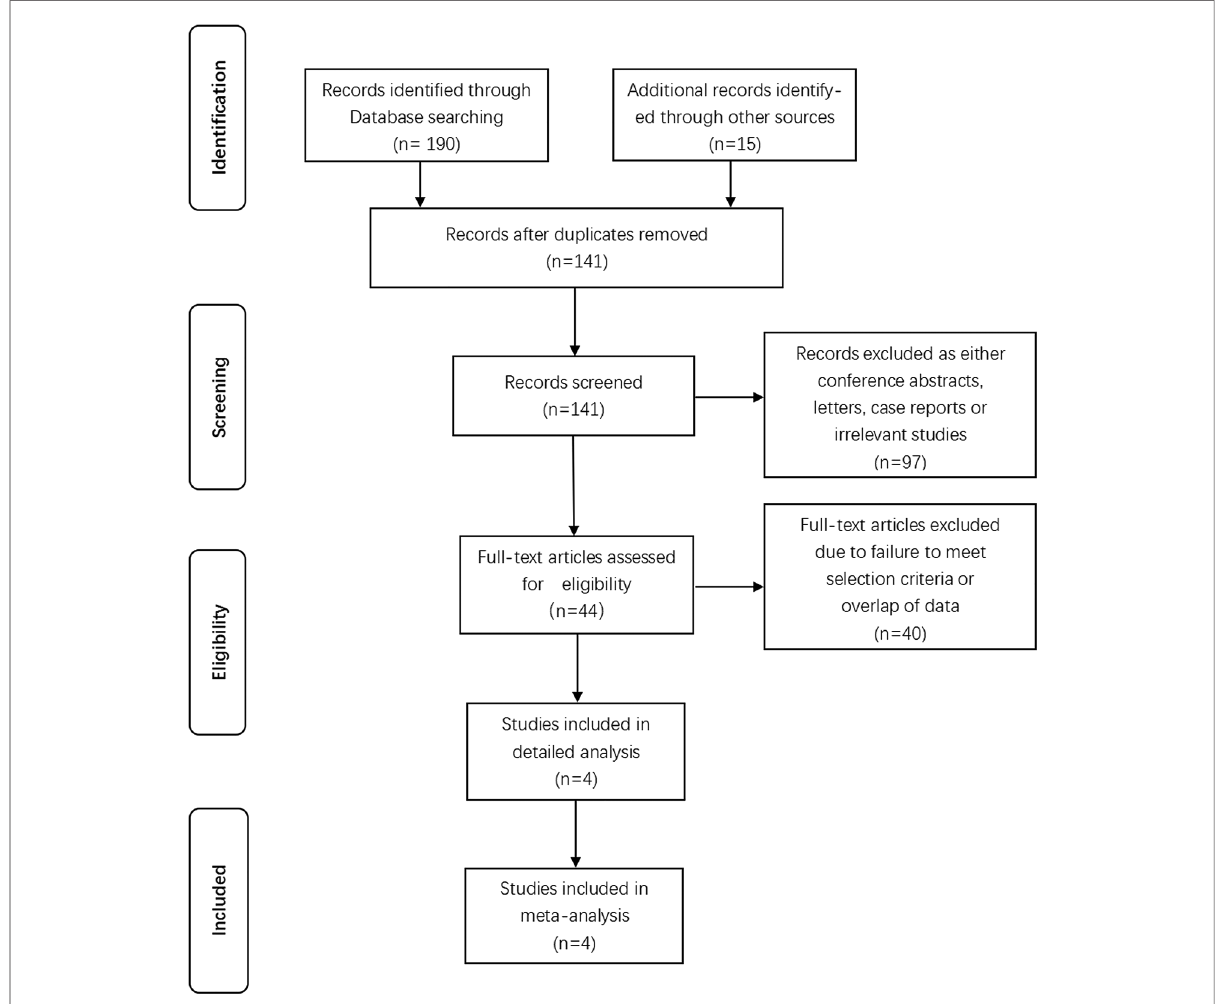
FIGURE 1 Preferred reporting items for systematic reviews and meta-analyses (PRISMA) fl ow